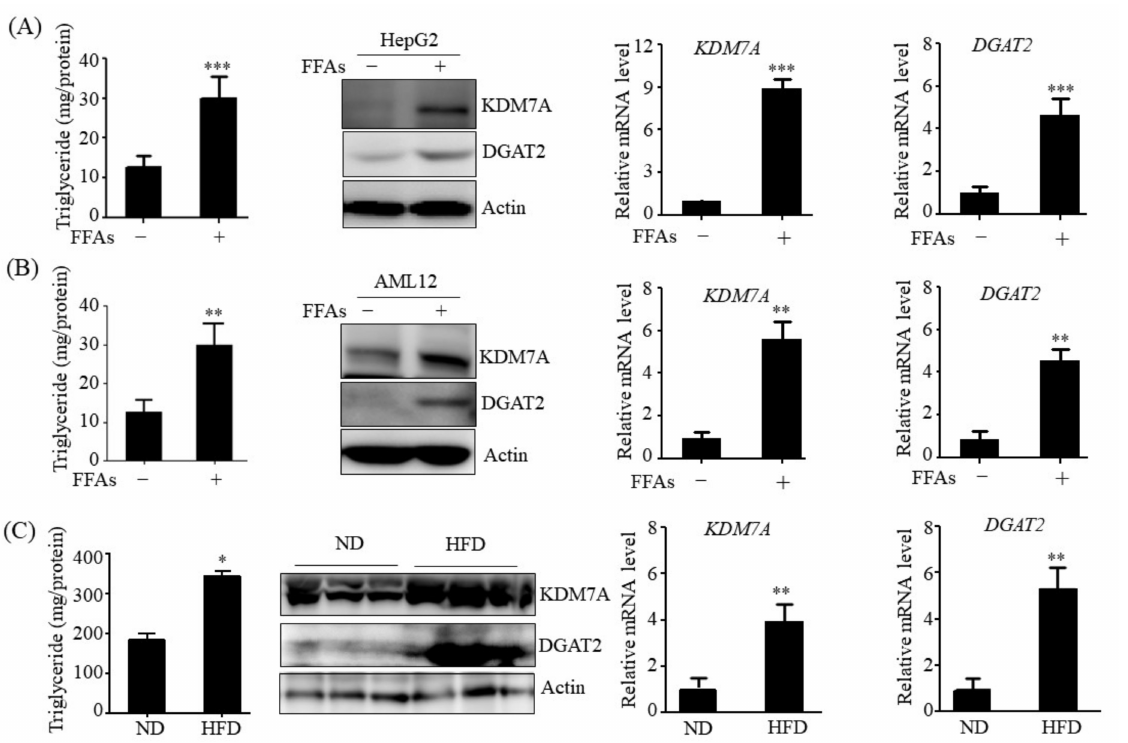
Figure 1. The expression of KDM7A and DGAT2 is increased in FFAs-treated HepG2 and AML12 cells and in the liver of HFD-fed obese mice. ( A , B ) HepG2 and AML-12 cells were incubated with 1 mM FFAs for 24 h. TG levels were measured by a TG assay kit. Protein levels of KDM7A and DGAT2 were measured by Western blotting. mRNA levels of KDM7A and DGAT2 were measured by qPCR. Data are presented as the mean ± SD from three independent experiments. ** p < 0.01, *** p < 0.001 vs. untreated control. ( C ) C57BL/6 mice were fed a normal diet (ND) or high fat diet (HFD) for 16 weeks. Hepatic TG levels were measured by a TG assay kit. Protein levels of KDM7A and DGAT2 were assayed by Western blotting. Representative Western blot analysis of KDM7A and DGAT2 is shown. mRNA level of KDM7A was measured by qPCR. Data are presented as the mean ± SD from 6 mice per group. * p < 0.05, ** p < 0.01 vs. ND